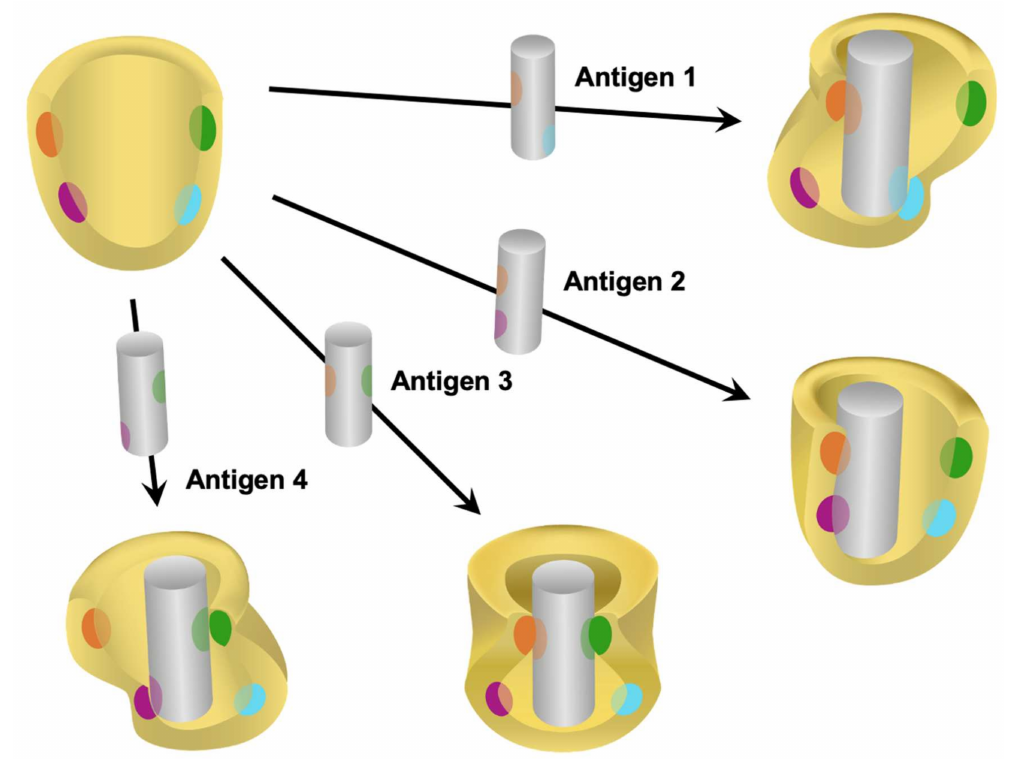
Figure 3. Schematic diagram showing the conformation hypothesis explaining polyreactivity. The classic ‘lock and key’ model of antigen-antibody interaction proposes rigid structures of interacting components and has been used for years to explain the monoreactivity of antibodies. Recent studies suggest that the antigen-binding ‘pocket’ of many antibody molecules is more flexible than previously thought and thus accommodate different antigenic configurations. Figure 3 shows four different antigens interacting with different amino acid residues within the antigen-binding pocket of a single broadly polyreactive antibody molecule. Each interaction alters the folding or conformation of the antigen-binding pocket in a different way. Figure modified from